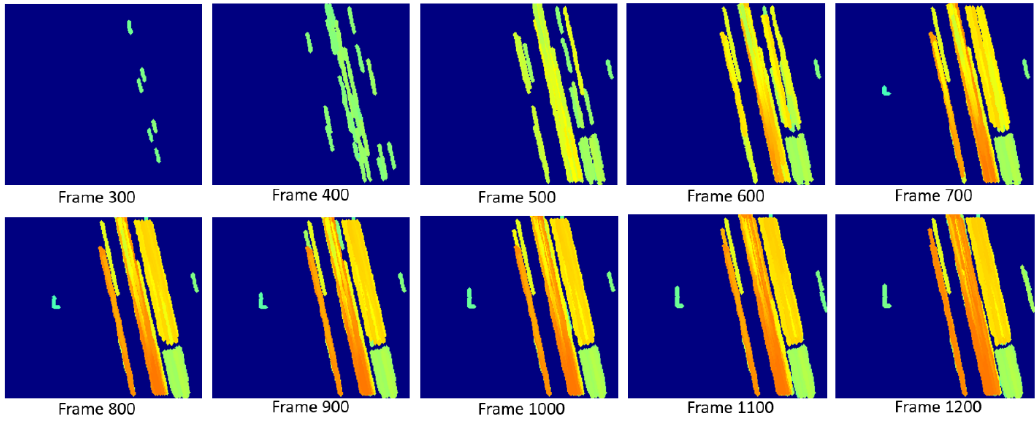
Figure 11. An example of a confidence map generated from tracklets.